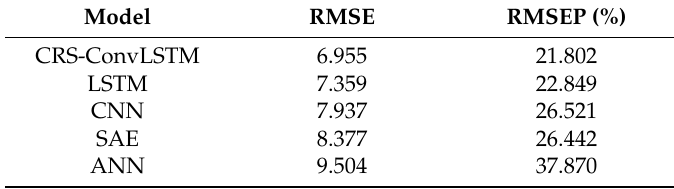
Table 4. Performance of different prediction models when α = 0.70.